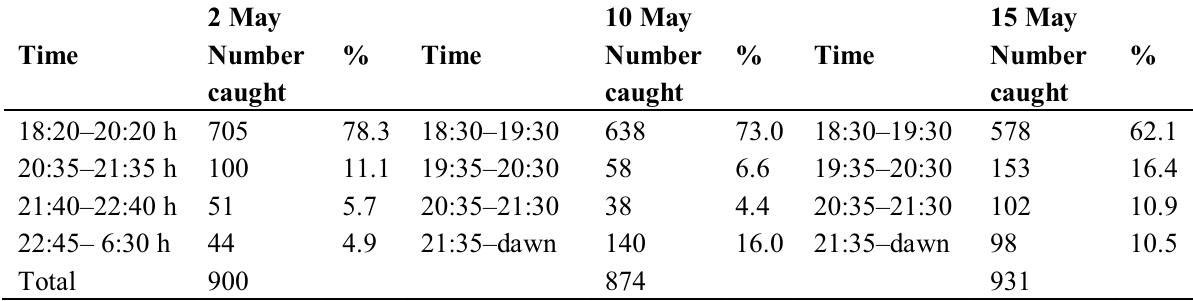
Table 4. Light trap catches of Cochliotis melolonthoides over time during the night: Absolute numbers and as a percentage of the total catch of that species for the night, May